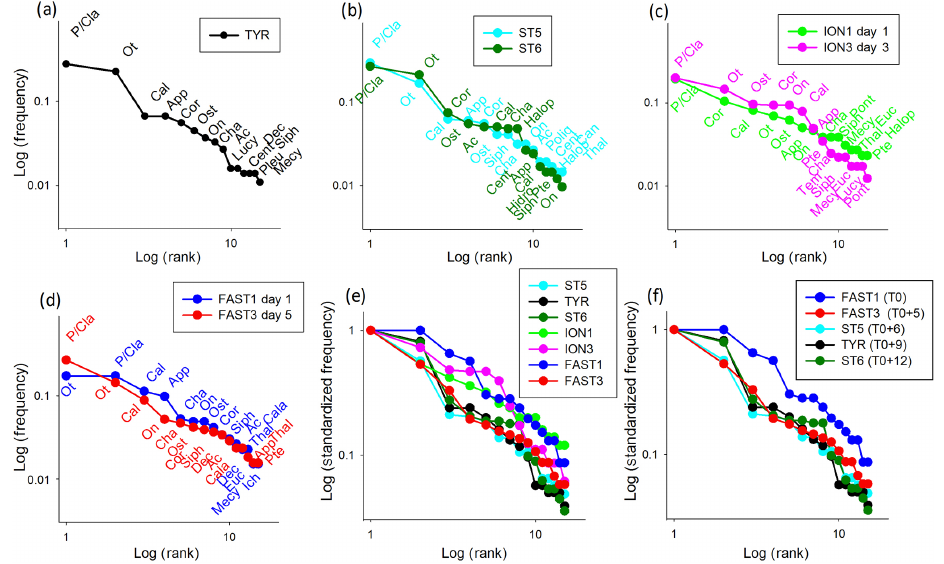
Figure 10. Rank frequency diagram at TYR (a) , ST5 and ST6 (b) , ION (c) , FAST (d) , and the Log-standardized frequency for all stations (e) and stations influenced by dust deposition (f) . Ac denotes Acartia spp., Cal denotes calanoid copepods, Cala denotes Calanus spp., Cent denotes Centropages spp., Cor denotes Corycaeus spp., Euc denotes Eucalanus spp., Halop denotes Haloptilus spp., Luci denotes Lucicutia spp., Mecy denotes Mecynocera spp., On denotes Oncaea spp., Ot denotes Oithona spp., P / Cla denotes Para/Clausocalanus spp., Pleu denotes Pleuromamma spp., Pont denotes Pontellidae, Tem denotes Temora spp., App denotes Appendicularia, Cha denotes Chaetognatha, Dec denotes decapods, Hydro denotes hydrozoans, Ich denotes ichtyoplankton, Ost denotes ostracods, Poly denotes Polychaeta, Pte denotes pteropods, Siph denotes siphonophores, and Thal denotes